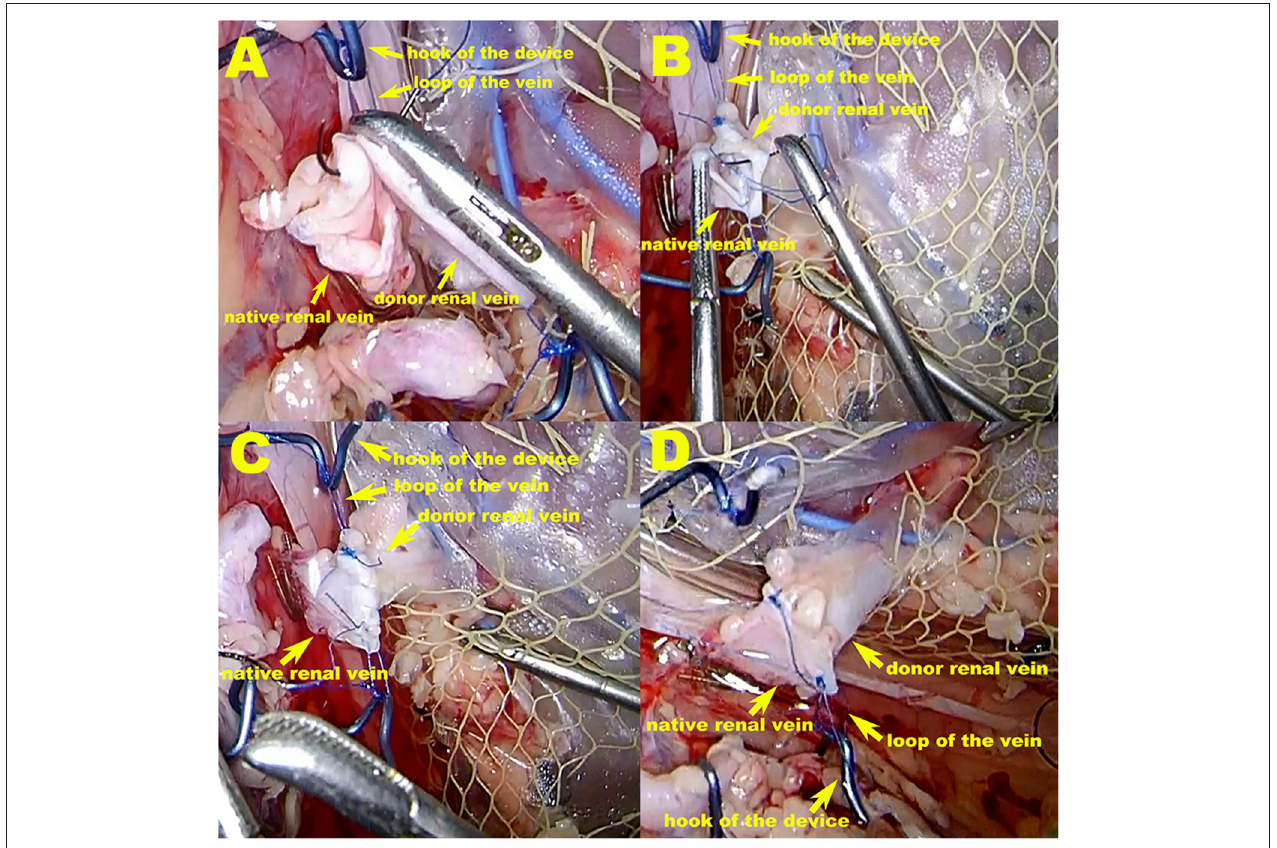
FIGURE 2 | The vascular prop device in operation in the VP group. (A,B) During the operation, the hook of the prop device holds the Prolene suture material loop to prop open the donor vein, thereby tightening the renal vessels at the maximum diameter. After vein-to-vein fixation at the upper and lower sites of the donor and native vein, respectively, the native vein is also supported and pulled out, which facilitates vein anastomosis. (C,D) Venous anastomosis completed. The purse-string effect at the vein anastomotic stoma, which can be seen in the VB group, is not possible because excessive suture contraction is